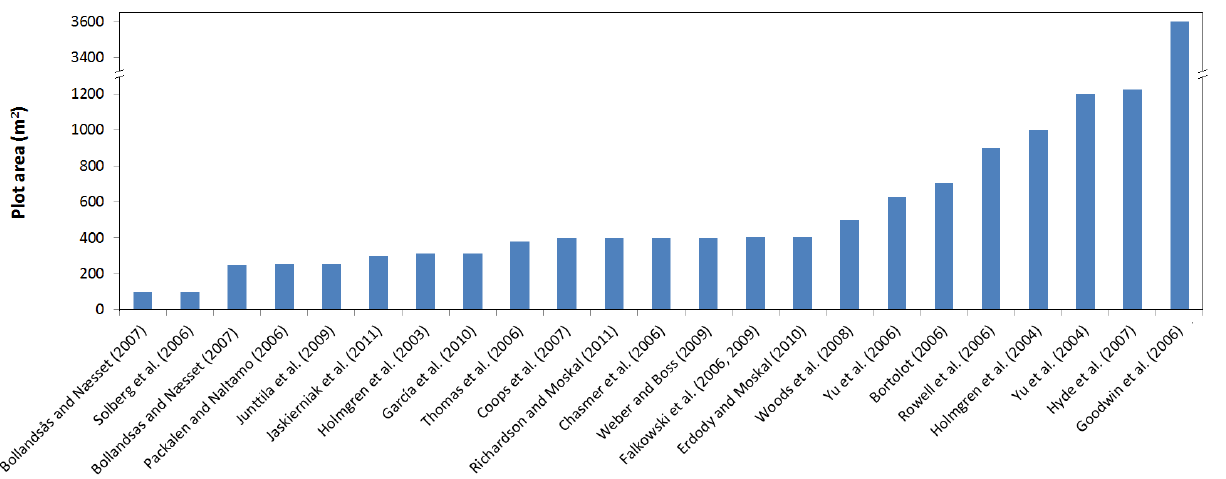
Figure 1. Plot sizes used by different authors over the last decade to study and create forest attribute models based on LiDAR